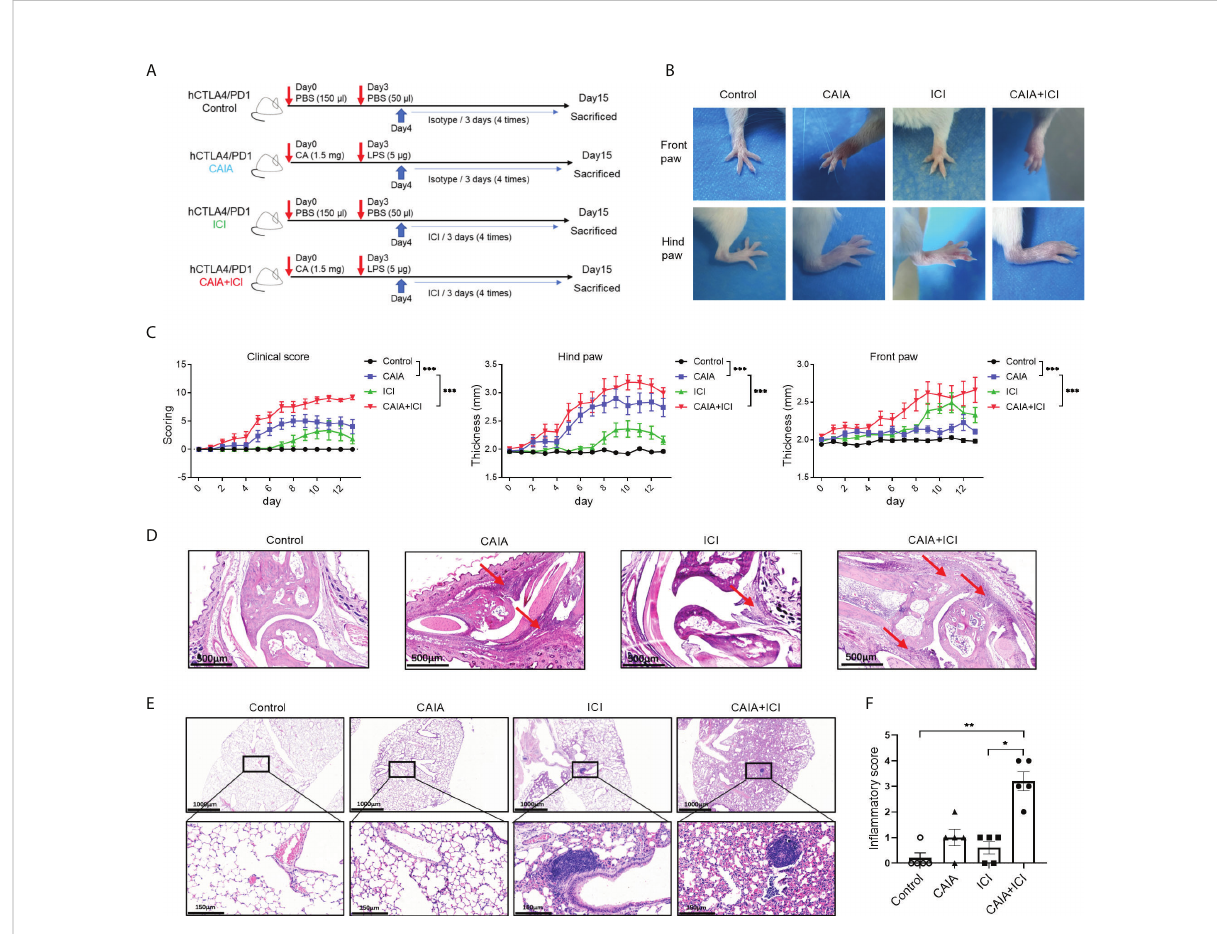
FIGURE 1 Establishment and histological characterization of ICI-related arthritis and pneumonitis in humanized mice. (A) A diagram illustrated the experimental design. (B) Representative images of paw swelling and ankle joints in mice. (C) The dynamics of clinical arthritis scores and paw thicknesses in mice. (D) Representative images of the ankle joints after hematoxylin-eosin (HE) staining in mice. Arrows indicate lymphocyte in fi ltrates and soft tissue injury. (E) Representative images of lung tissues in mice after HE staining. (F) in fl ammatory scores in lung tissues of mice. Data are representative images or presented as means ± SEM (n=6) of each group of mice. Statistical signi fi cance was analyzed by two- way ANOVA and post hoc Bonferroni test or the Kruskal-Wallis H test. * p < 0.05, ** p < 0.01. *** p <